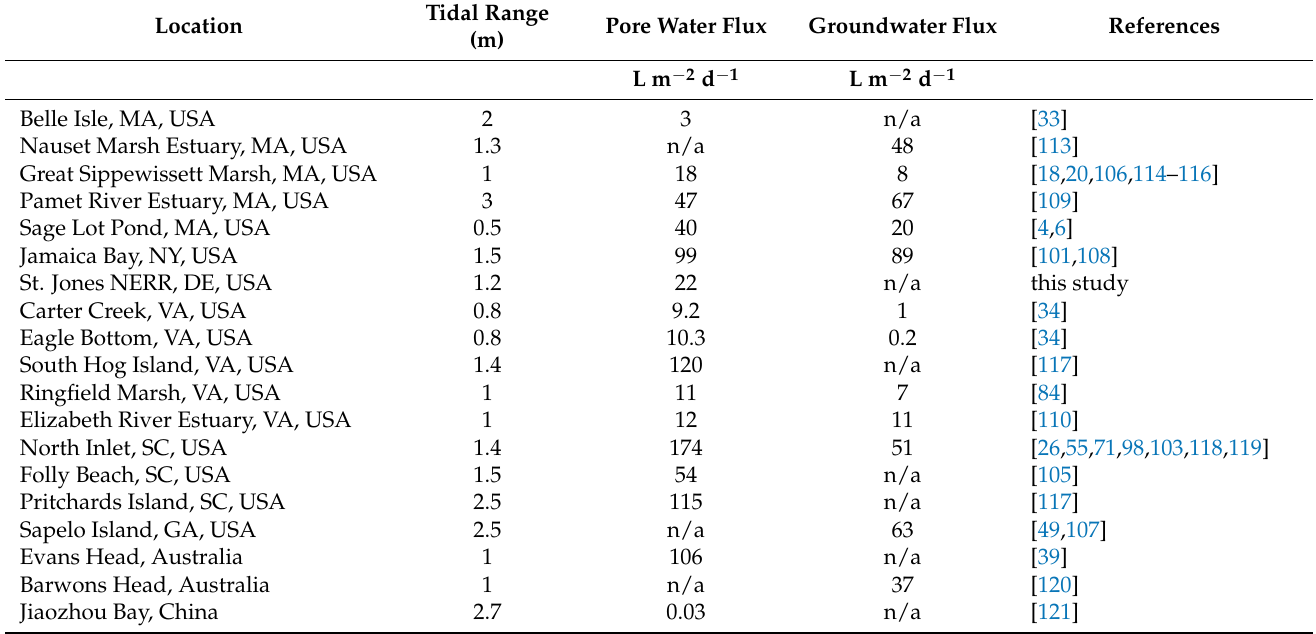
Figure 6. Map of the East Coast of the Unites States showing compiled salt marsh field sites with average PEX depicted by color and the average SGD rate depicted by symbol size. Dashed lines approximately delineate the Mid-Atlantic and South Atlantic Bights. Table 2. Summary of average area-normalized marsh porewater and groundwater flux estimates, derived from Table S1. Groundwater includes brackish and freshwater fluxes. Note that tidal range for each site is an approximation. n/a indicates “not